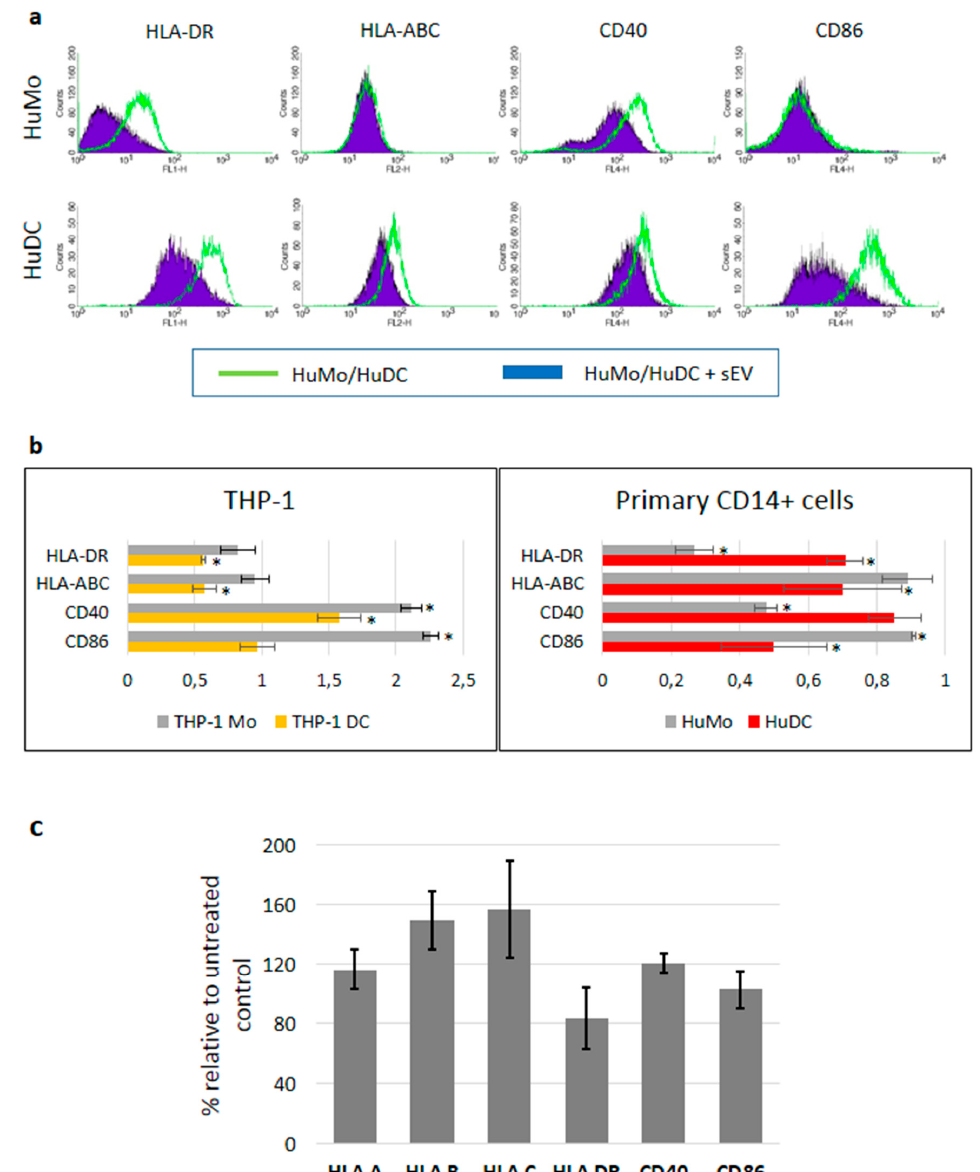
Figure 3. Melanoma cell-derived sEVs modulate the immune receptor expression on APCs. ( a ) Upper panel: The cell surface expression of MHC class I, II, CD40, and CD86 of CD14 + primary human monocytes (HuMo) was measured by flow cytometry (green lines). Overlaid are the histograms after exposure to A375 melanoma-derived sEVs for 48 hours (filled violet peaks; representative of n = 6). Lower panel: HuMo were di ff erentiated into DCs (HuDC) and exposed to sEVs for 48 hours and the cell surface expression was analyzed by flow cytometry, as above (representative of n = 3). ( b ) The mean fluorescence intensities (MFI) of the surface expression of MHC class I, II, CD40, and CD86 after exposure to melanoma-derived sEVs was related to the MFI of unexposed cells. Both monocytes and DCs derived from either the THP-1 cell line (left diagram) or primary human CD14 + cells (right diagram) were used in the experiments. At least three independent experiments were conducted for each cell type and significant di ff erences were marked by asterisks (Student’s t-test). ( c ) The mRNA expression levels in DC cells derived from the peripheral blood of healthy donors treated with A375-derived sEVs relative to untreated control cells. Mean values and standard deviations are shown from three independent experiments. The di ff erences between samples after sEV exposure and untreated controls did not reach statistical significance (Student’s t